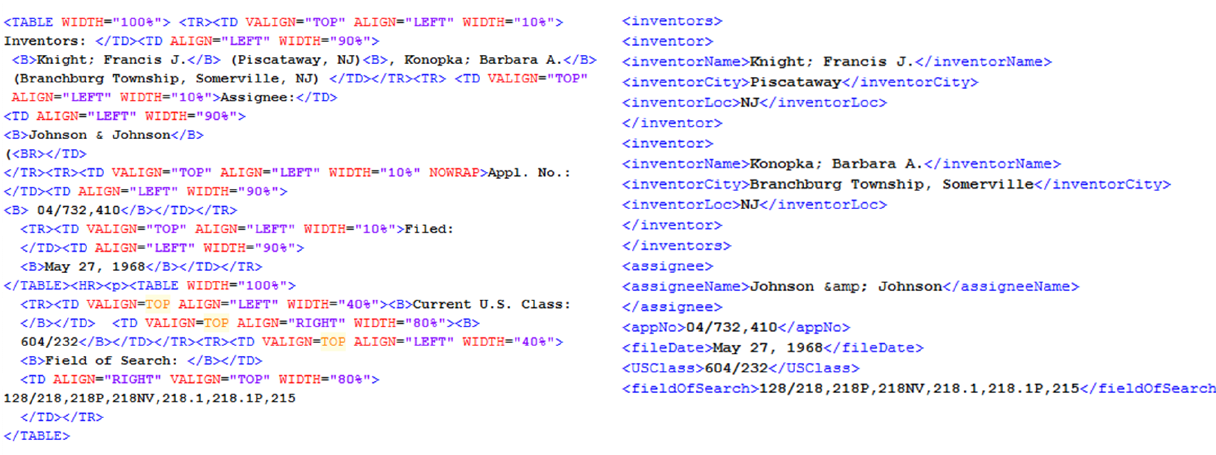
Figure 2. HTML content, on the left, and the resulting XML content, on the right.